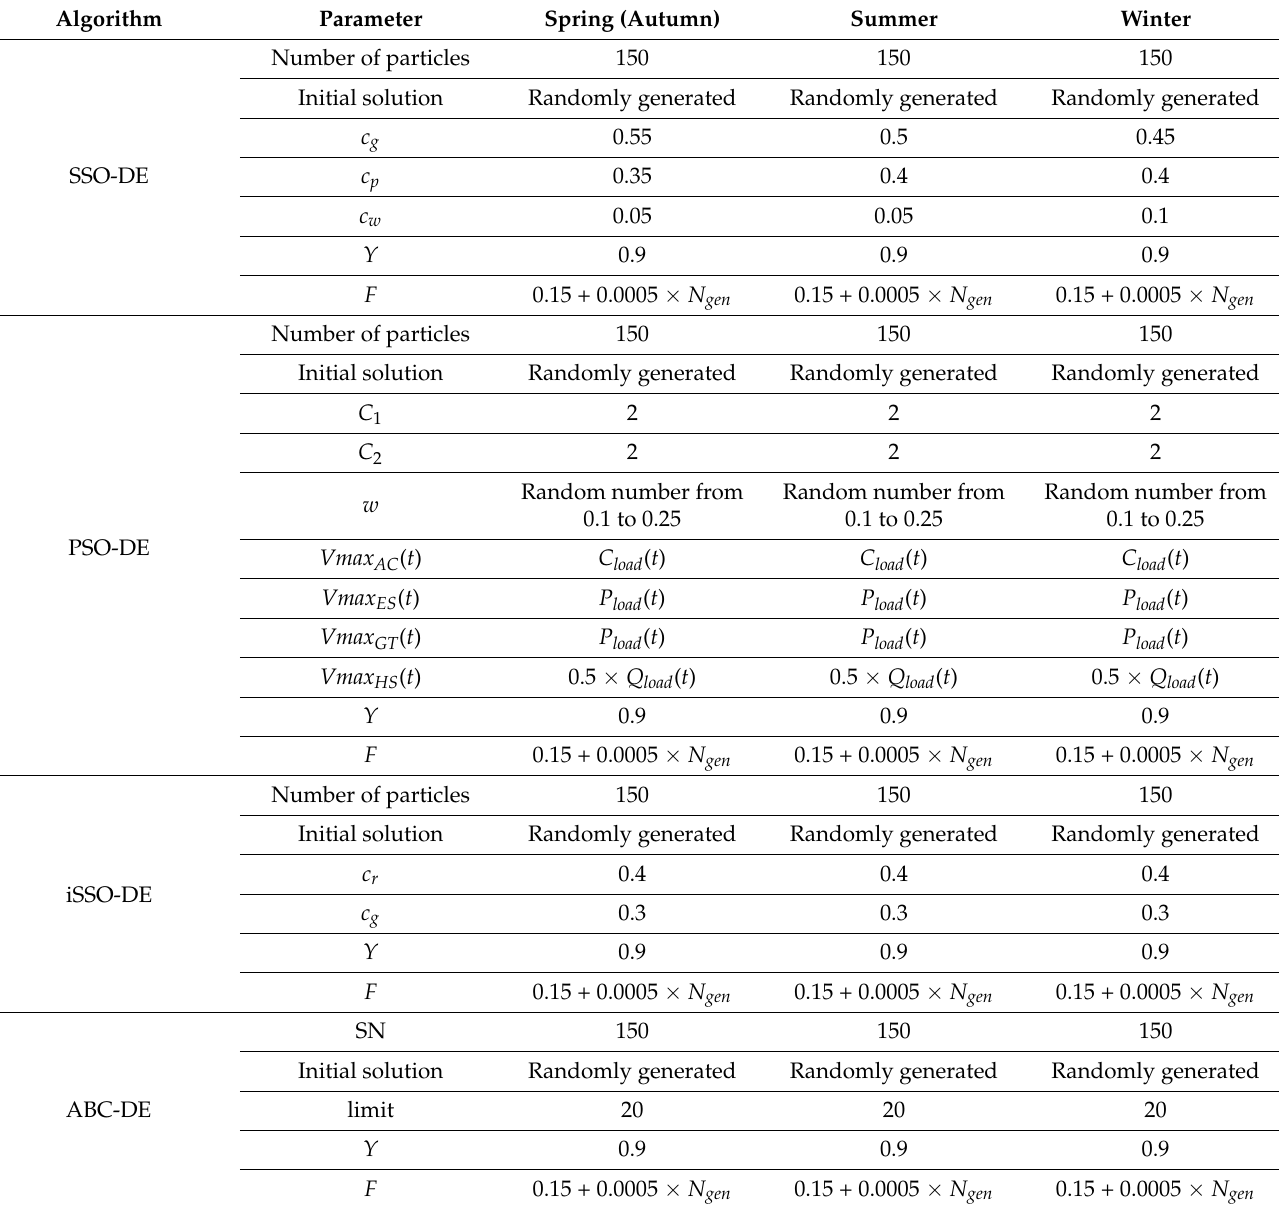
Table 16. Parameter configuration of each algorithm.